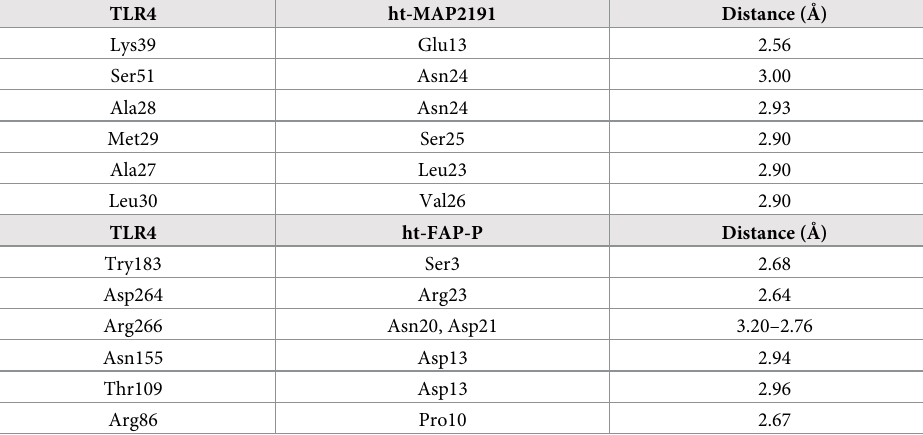
Table 7. Amino acids involved in hydrogen-bonding